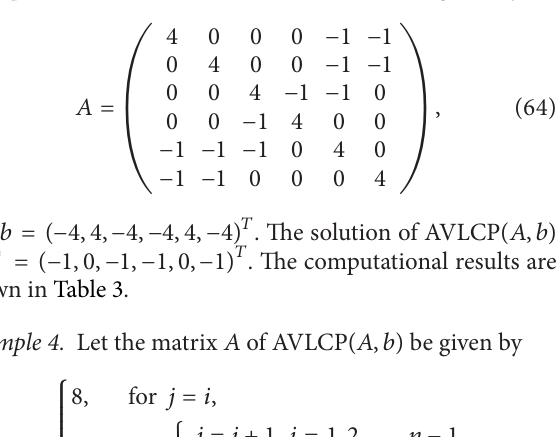
Table 4: Computational results of Example